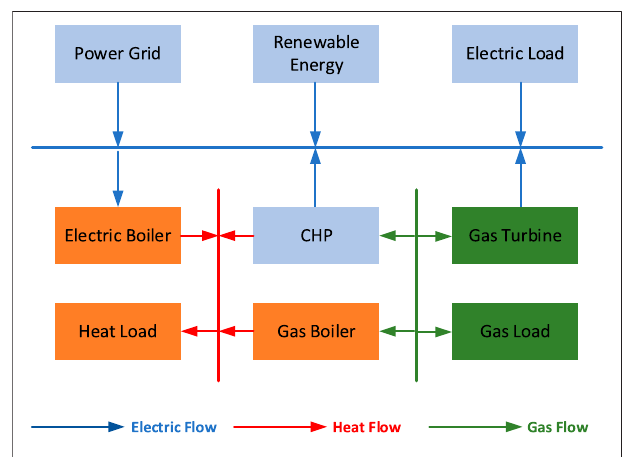
FIGURE 1 | Integrated energy